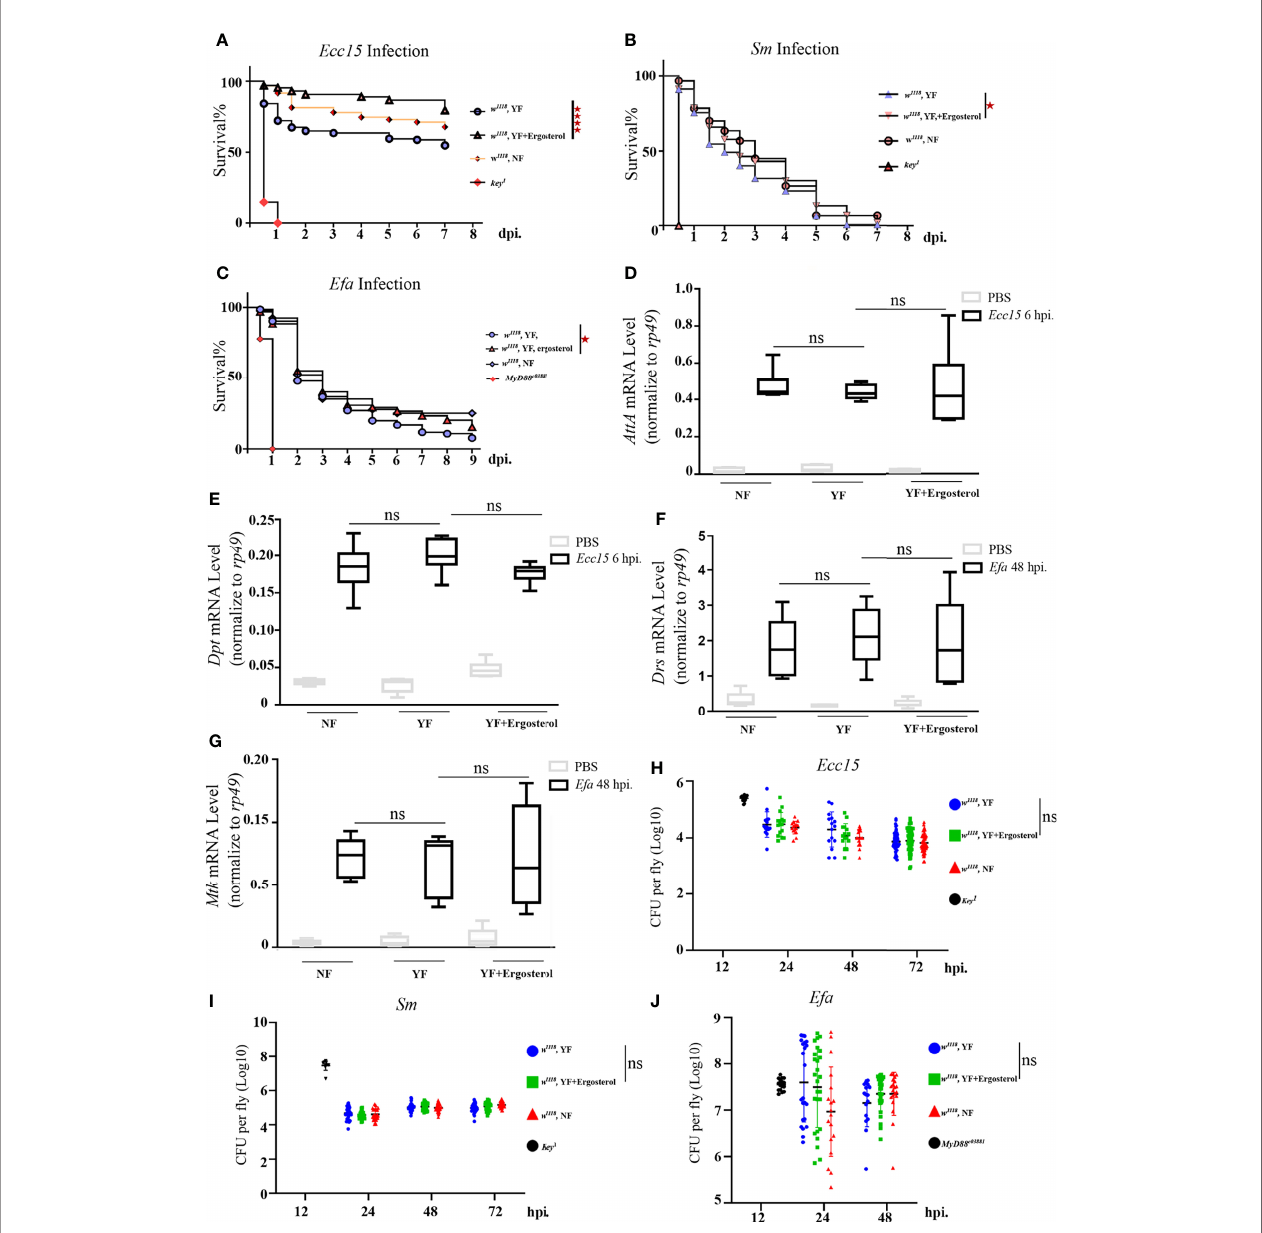
FIGURE 2 | Ergosterol is required for host defense of bacterial infection in Drosophila . (A – C) . Survival curves of w 1118 and key 1 or Myd88 c03881 fl ies infected with Ecc15 (A) , S.m (B) , and E.fa (C) , reared on different food. ****, p<0.0001 (Log-rank test). (D, E) . Q-PCR plot of AttA and Dpt mRNA level in fl ies infected with Ecc15 at 6hpi, reared on different food. ns, not signi fi cant. (One-way ANOVA test with a Sidak test). (F, G) . Q-PCR plot of Drs and Mtk mRNA level in fl ies infected with E.fa at 48hpi, reared on different food. ns, not signi fi cant. (One-way ANOVA test with a Sidak test). (H – J) . CFU assay of w 1118 and key 1 or Myd88 c03881 fl ies infected with Ecc15 (H) , S.m (I) , and E.fa (J) , reared on different food. ns, not signi fi cant. (One-way ANOVA test with a Sidak test). NF, normal food; YF, yeast-free food; YF +ergosterol, yeast-free food containing ergosterol (100